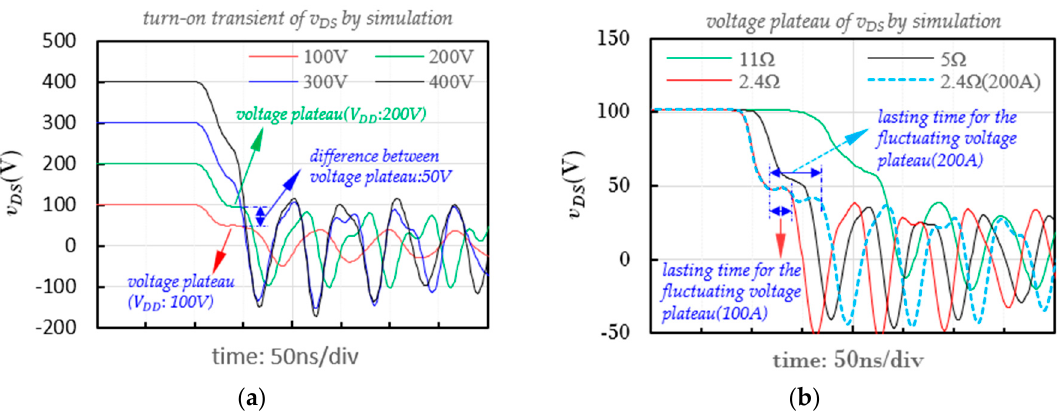
Figure 13. The simulation results about voltage plateau of v DS for module_D by LTspice: ( a ) influence of V DD , ( b ) influence of turn-on speed.